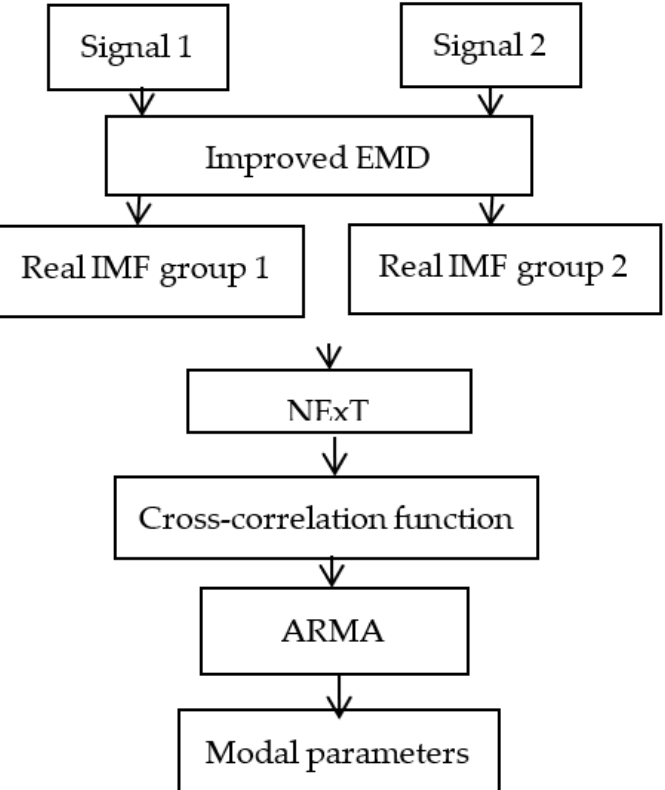
Figure 2. Diagram of using IEMD and ARMA to identify structural parameters.